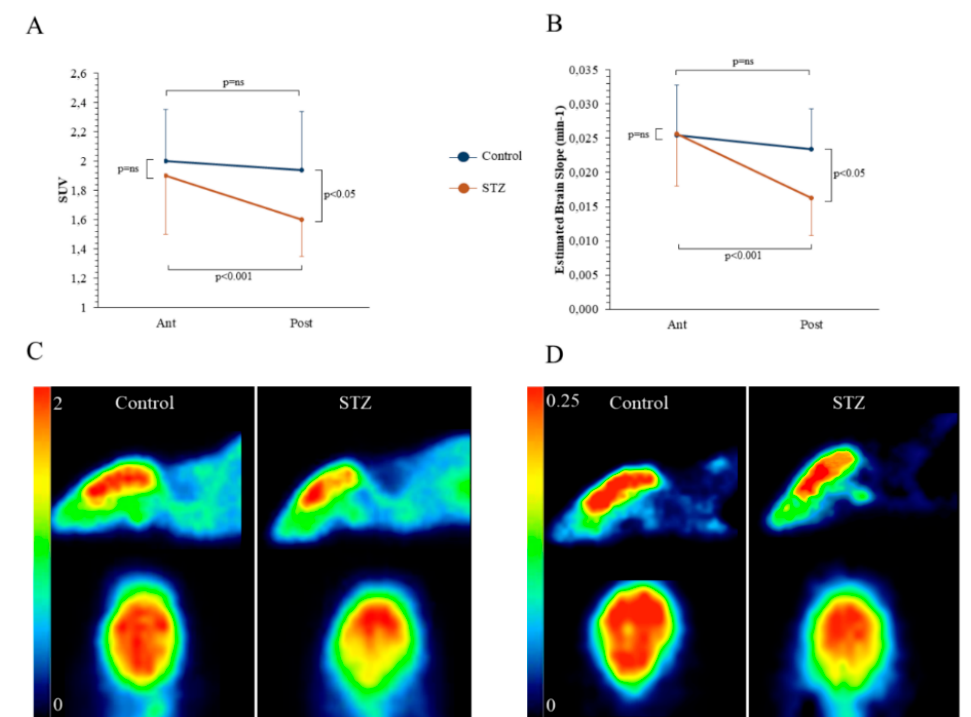
Figure 2. In vivo effects of hyperglycemia on Standardized Uptake Value (SUV) and slope of Patlak. Average SUV (Panel A ) and slope of Patlak regression line ( k 1 × k 3 )/( k 2 + k 3 ) (Panel B ) of anterior (Ant) and posterior (Post) brain areas in control ( n = 17, blue) and STZ mice ( n = 23, brown). Hyperglycemia significantly decreased both parameters in posterior brain regions. Representative images of axial and sagittal projection representing the average SUV (Panel C ) and the parametric reconstruction of the Patlak slope (Panel D ).